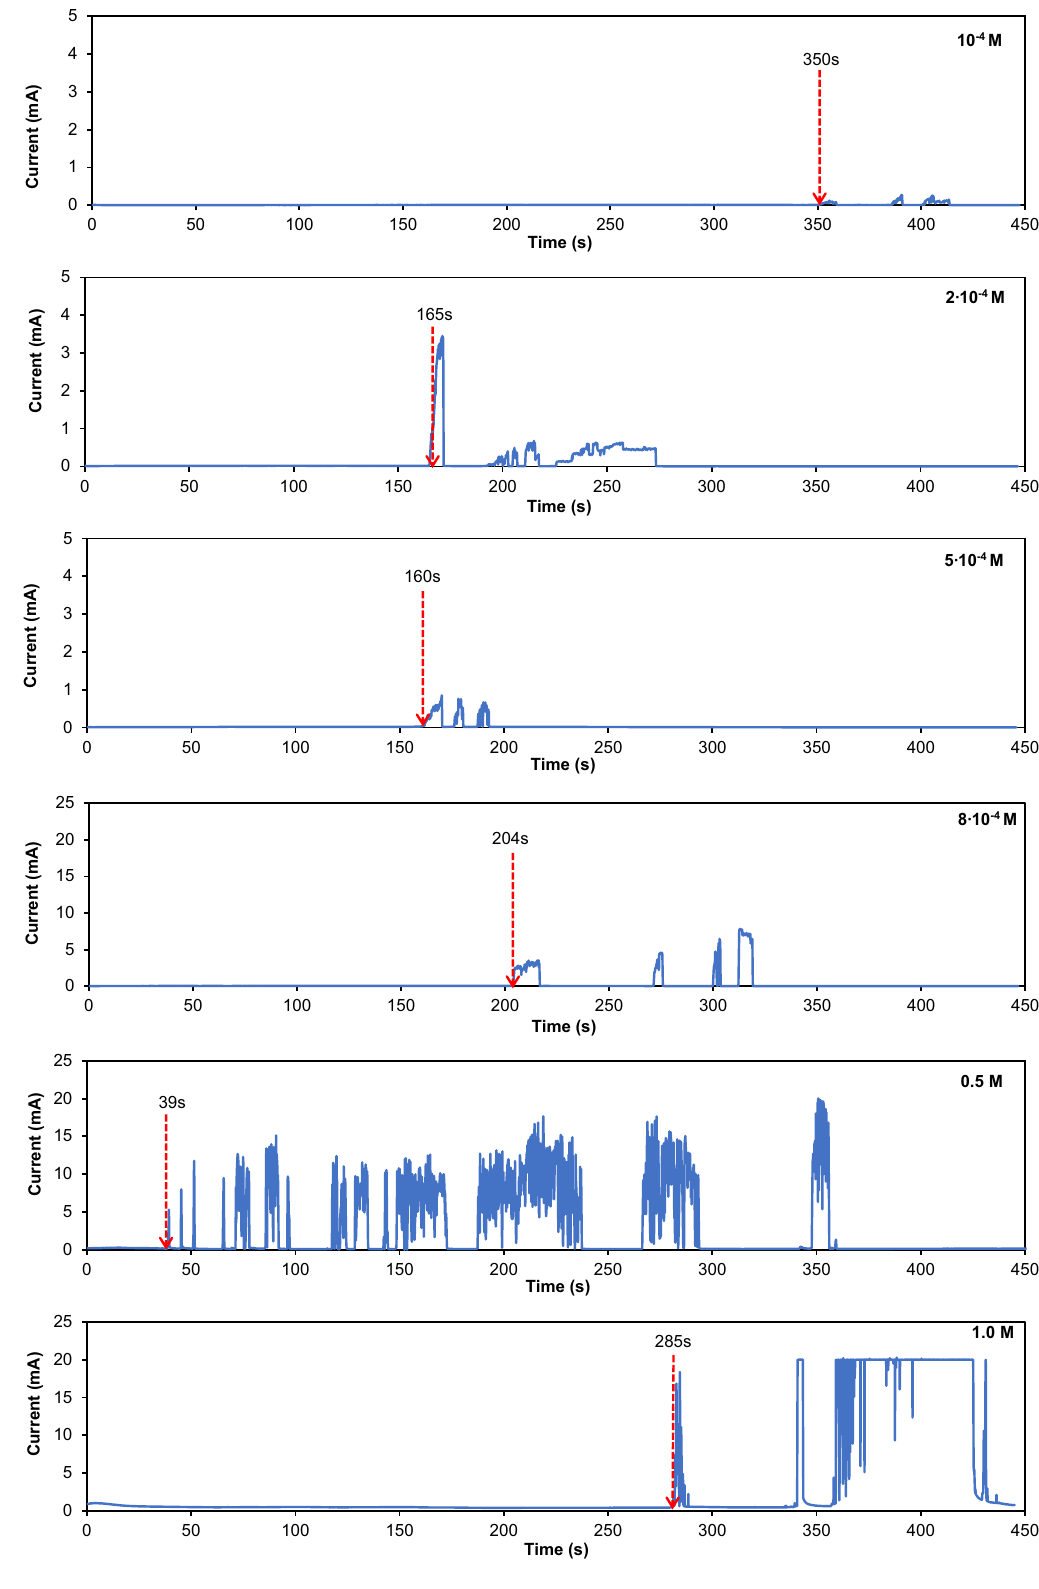
Figure 3. Current vs. time curves for the ECM of Sn at various Br − concentrations and applied bias of 3 V. Red arrows pinpoint the time of the first current surge or the